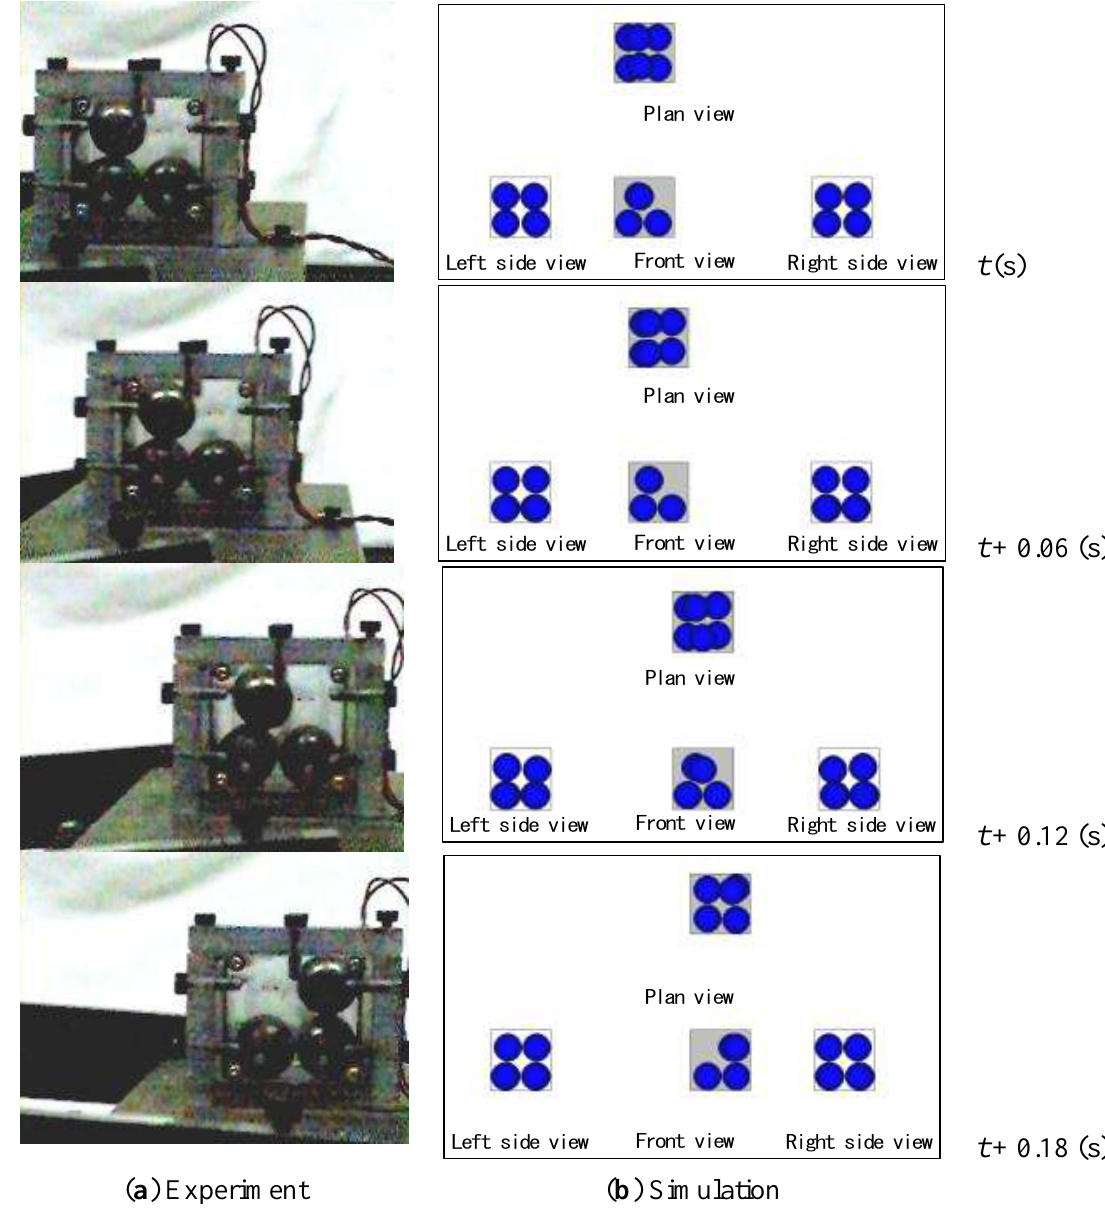
Figure 4. Flow condition ( P d = 19.1 mm, D = 50 mm, f = 3 Hz, F r =